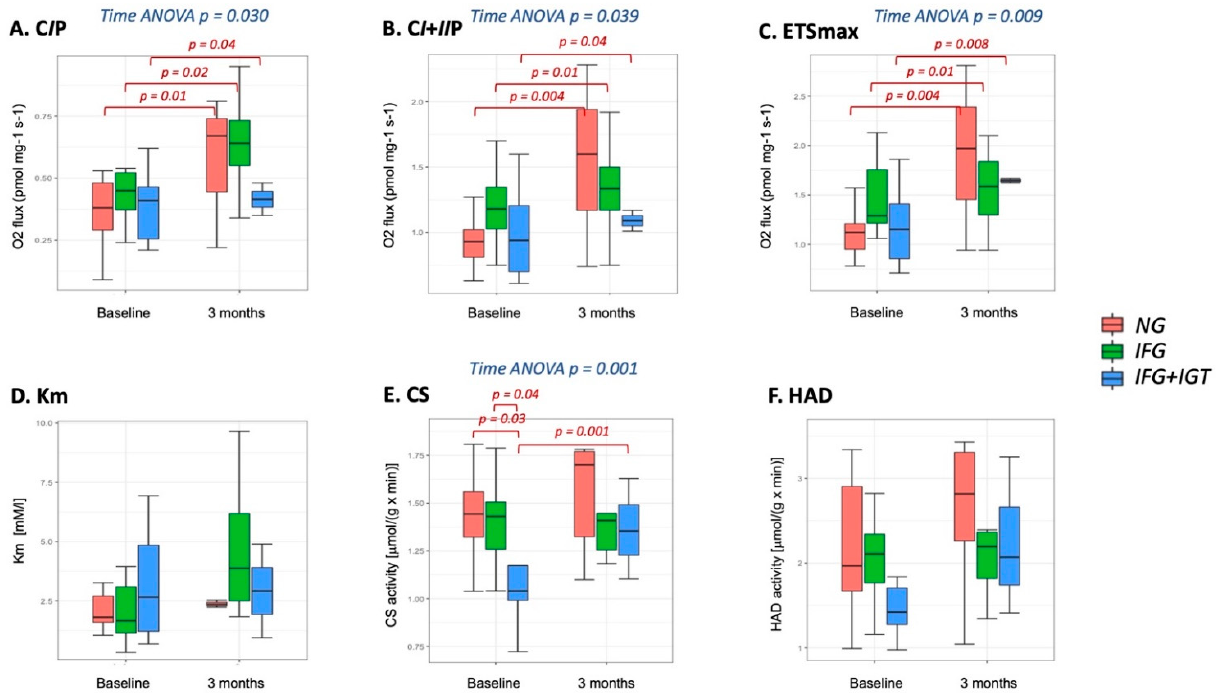
Figure 4. ADIPOSE TISSUE mitochondrial content (via citrate synthase activity) and mass-specific respiratory capacity parameters in patients with Normoglycemia (NG), isolated Impaired Fasting Glucose (IFG) and Impaired Fasting Glucose and Impaired Glucose Tolerance (IFG + IGT), before and after 3 months of exercise intervention. ( A ). Complex I-linked OXPHOS capacity (CIP); ( B ). Maximal complex I + II -linked OXPHOS capacity (CI + IIP), ( C ). maximal capacity of the electron transfer system (ETSmax); ( D ). Km for succinate titration, ( E ). Citrate Synthase (CS) activity. ( F ). β -hydroxy-acyl- CoA dehydrogenase (HAD) activity. Square root transformation was performed to calculate model-based means and 95% CI.